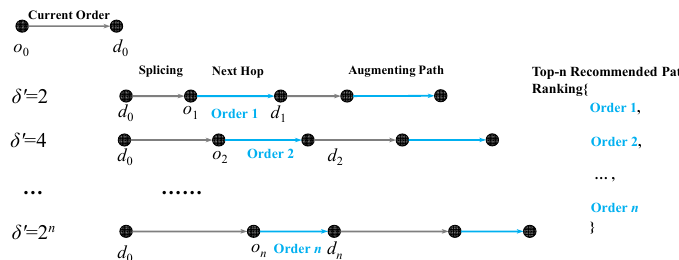
Figure 4. Different constraints generate different pickup paths.